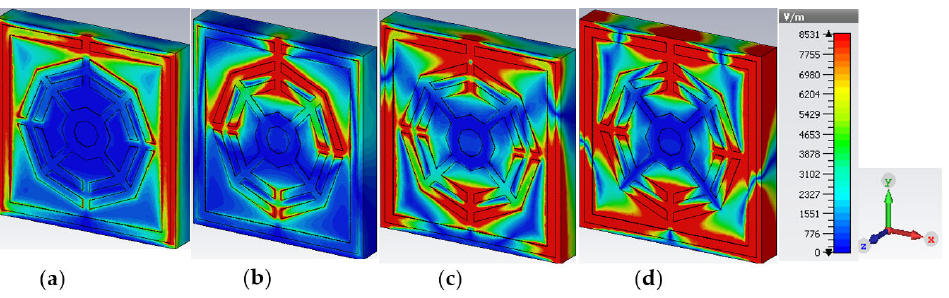
Figure 10. Electric field distribution at ( a ) 2.35 GHz ( b ) 7.72 GHz ( c ) 9.23 GHz and ( d ) 10.68 GHz.